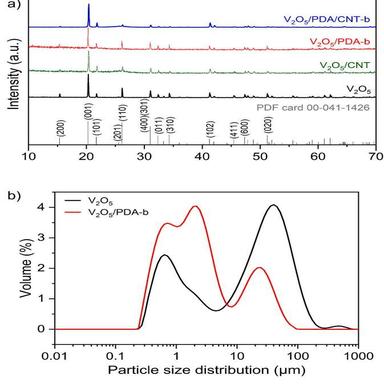
a) X-ray diffraction patterns of V2O5 and V2O5/PDA-b materials, V2O5/ CNT and V2O5/PDA/CNT-b electrodes. b) Particle size distribution of the V2O5 and V2O5/PDA-b materials in water.